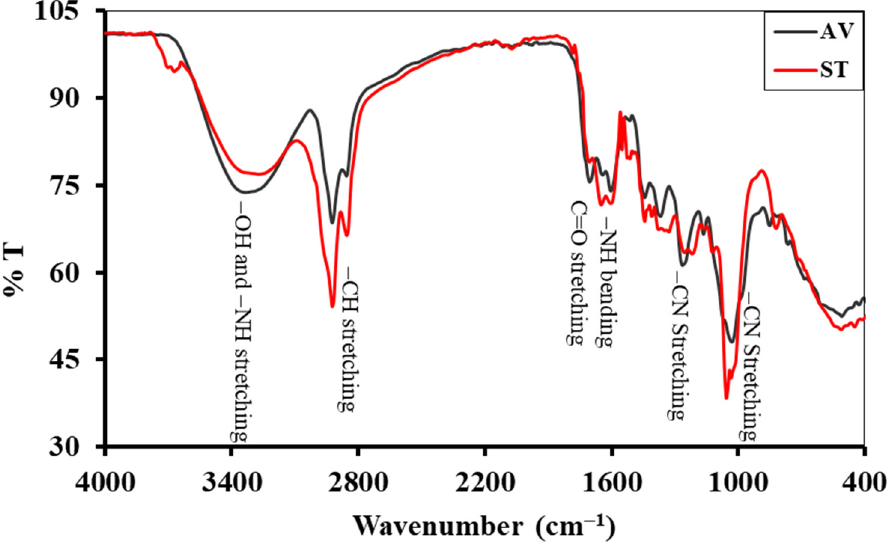
Figure 1. FTIR spectrum of alkaloid extract of AV and ST.